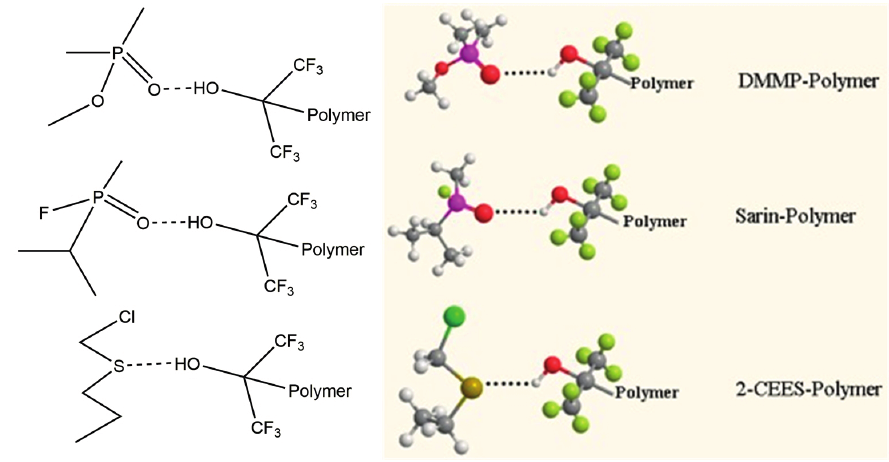
Figure 10. Hydrogen-bonding interactions between DMMP, sarin, 2-CEES and HBA polymer